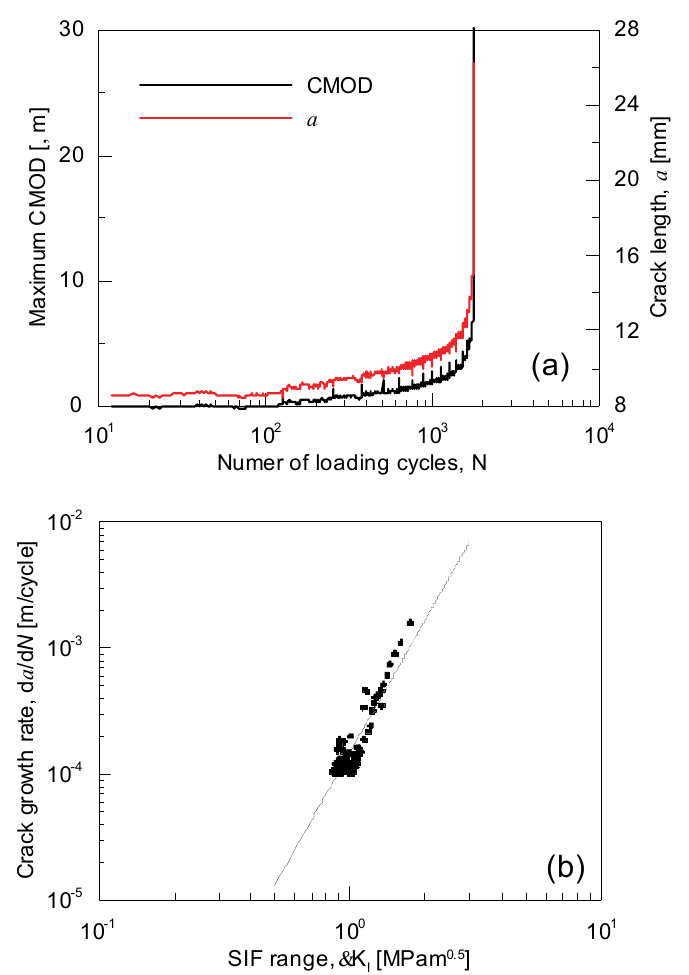
Figure 4: Fatigue crack growth data (a) and d a /d N -  K I plot (b) for a notched specimen with  